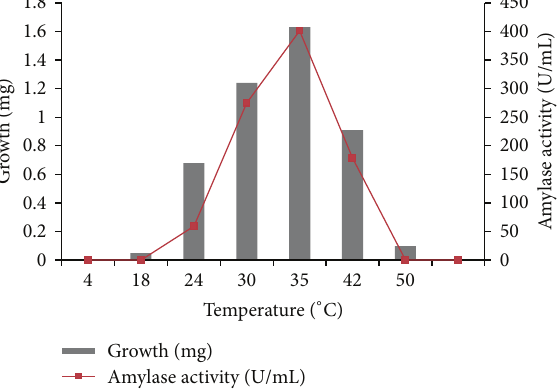
Figure 5: Effect of incubation temperature on growth of BTSS1001 and amylase production.